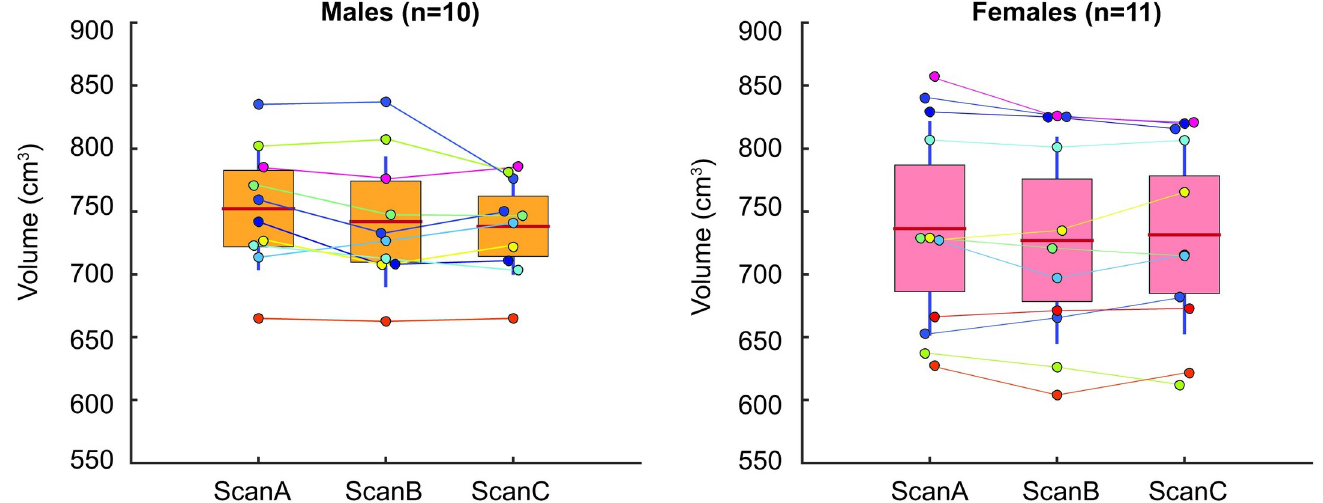
Fig 5. Total body volume estimated with our proposed 3D method for both males and females. Comparison volumes between the three scans (Scan A-C) are shown for each participant (coloured dot). The box is the 95% confidence interval around the mean (red line) and SD about the mean is shown (vertical blue line).